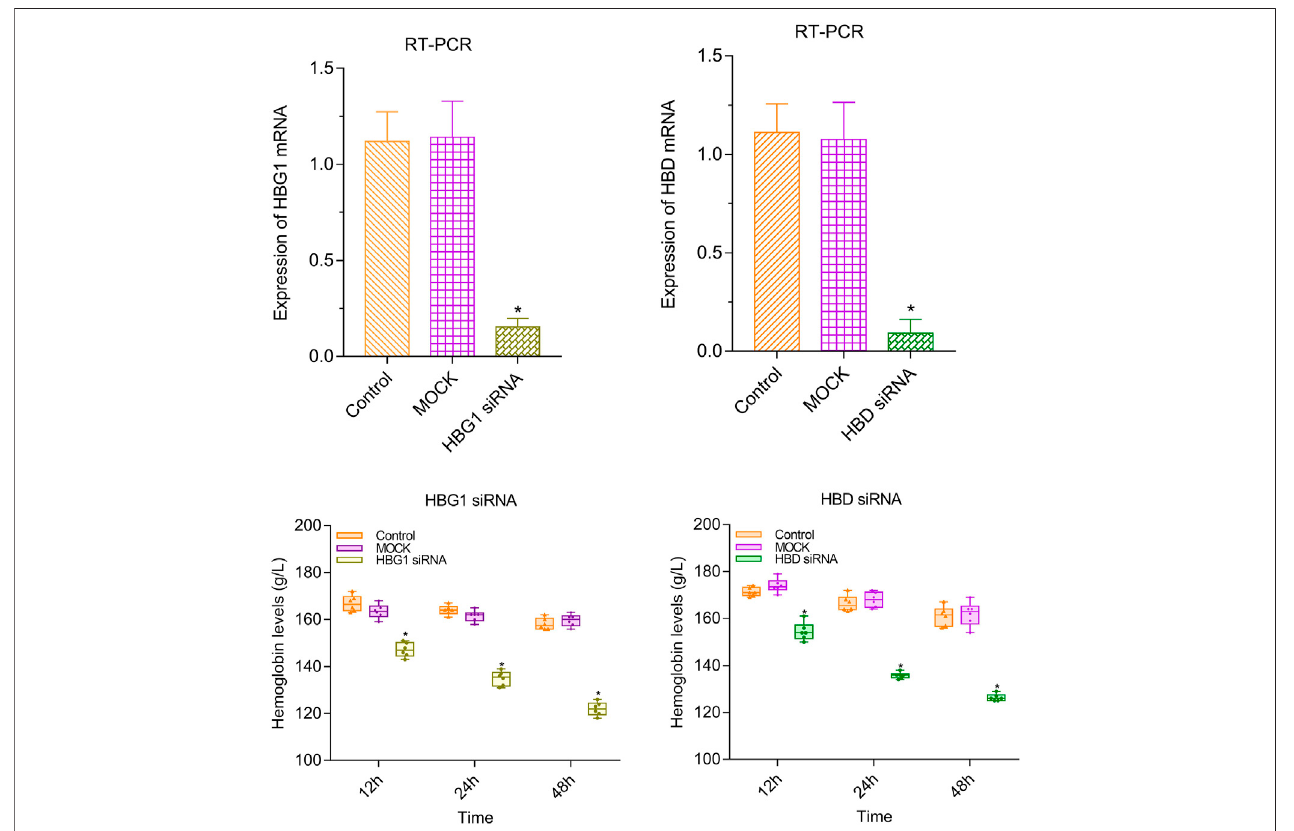
FIGURE 2 | Lower level of hemoglobin in the red blood cells with HBG1-siRNA and HBG1-siRNA than the CON red blood cells.